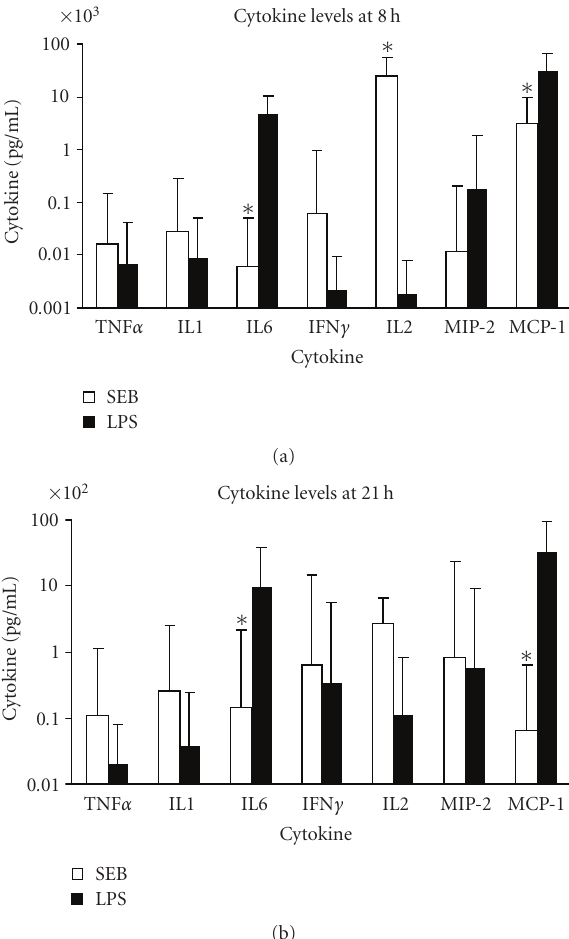
Figure 3: Serum levels of TNF α , IL-1, IL-6, IFN γ , IL-2, MIP-2, and MCP-1 at (a) 8 hours after SEB or LPS administration (b) 21 hours after SEB or LPS administration. Points represent the geometric mean ± standard deviation (SD) for each group. SEB group consisted of mice treated with 100 μ g SEB and LPS group was treated with 80 μ g LPS. The “ ∗ ” indicates P < .05 between groups treated with SEB or